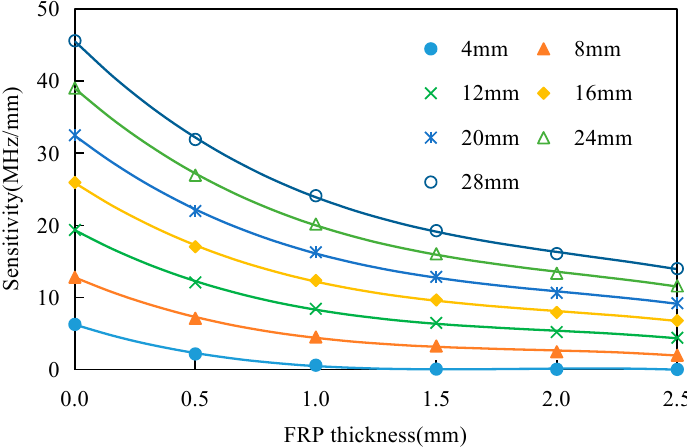
Figure 15. Effects of Fiber Reinforced Polymer (FRP) thickness on the antenna sensor’s sensitivity.